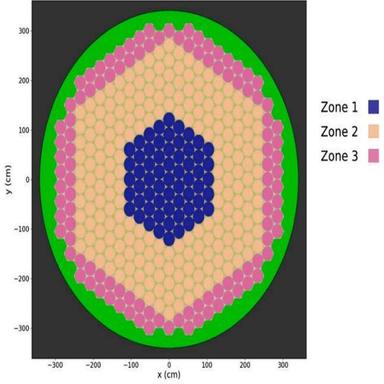
Radial view of the core. The radial zones that were used to study graphite damage are represented.